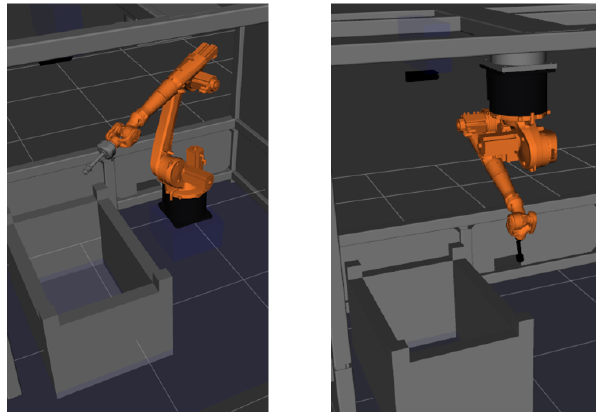
Figure 11. Pose of the robot for reachability study.